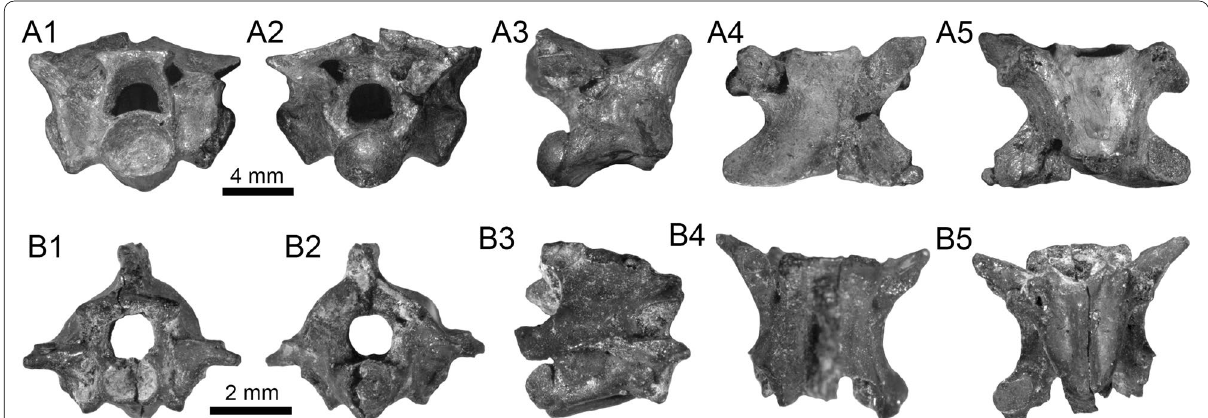
Fig. 9 Serpentes from the Iquitos assemblage. A1 – A5 Mid‑trunk precloacal vertebra of † Colombophis portai (PIMUZ A/III 4578). B1 – B5 Mid‑trunk precloacal vertebra of Colubroidea indet. (PIMUZ A/III 4621). Views: anterior ( A1 , B1 ), dorsal ( A4 , B4 ), right lateral ( A3 , B3 ), Posterior ( A2 , B2 ), and ventral ( A5 , B5